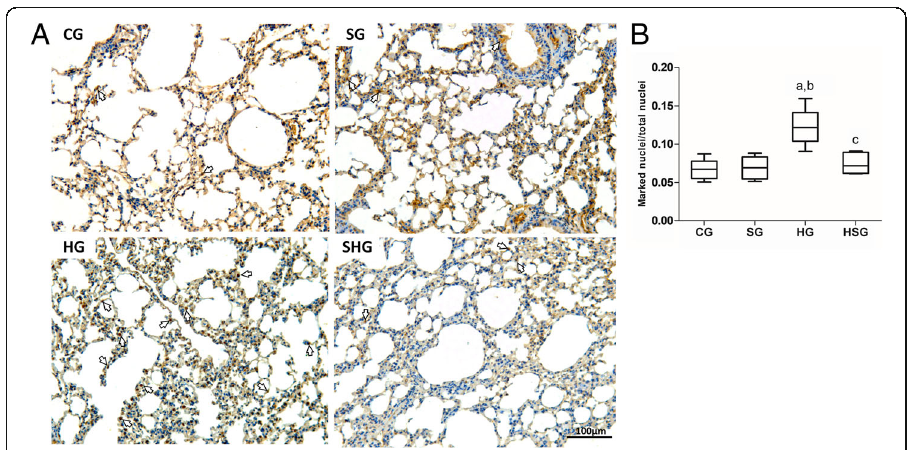
Fig. 2 Immunohistochemistry for HMGB1. a Histological section of lung parenchyma stained by immunohistochemical technique. Barr = 100 μ m. The arrows point to marked nuclei. b Ratio between the number of nuclei labeled for HMGB1 antibody and the total number of nuclei. Data are expressed as mean ± SD ( n = 9). (a) represents a significant difference between the groups when compared to the CG; the letter (b) is significant difference between the groups when compared to the SG, and letter (c) represents a significant difference between the groups when compared to the HG. Data were analyzed by